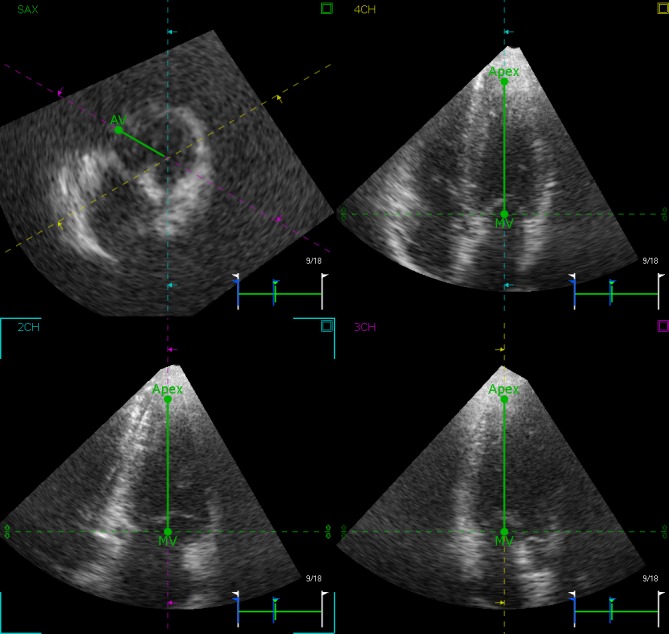
Three-dimensional speckle-tracking echocardiography (3D STE) offline analysis.First, the long axis (LAX) view is selected. The mitral valve landmark is placed at the annular level in the middle of the mitral valve, and the apical landmark is placed at the apex. Then, the short-axis view is selected. The aortic valve landmark is placed at valve level in the middle of the aortic valve. Manual tracking revision is performed if needed.